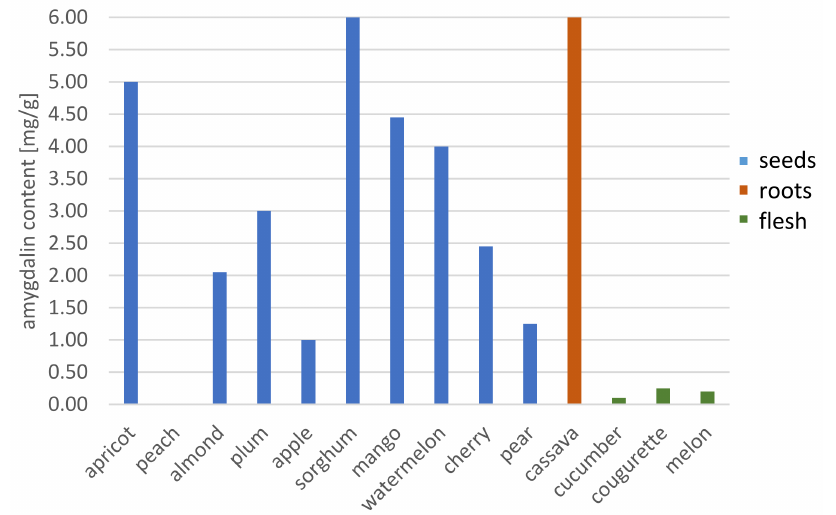
Figure 6. Changes in the amygdalin content in edible